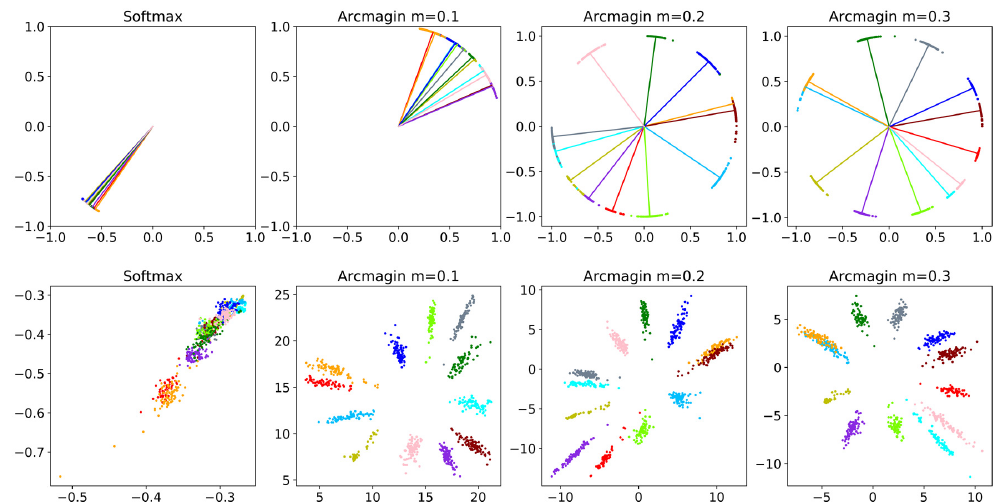
Figure 9. Testing softmax and arcmargin losses on the PAMAP2 validation dataset with 2D features. In this experiment, we used a CNN model to learn 2D features on the validation set of the PAMAP2 dataset. To realise this, we set the output dimension of the first fully-connected layer to 2. The first and second rows are the features in Euclidean space and angular space, respectively. Dots of